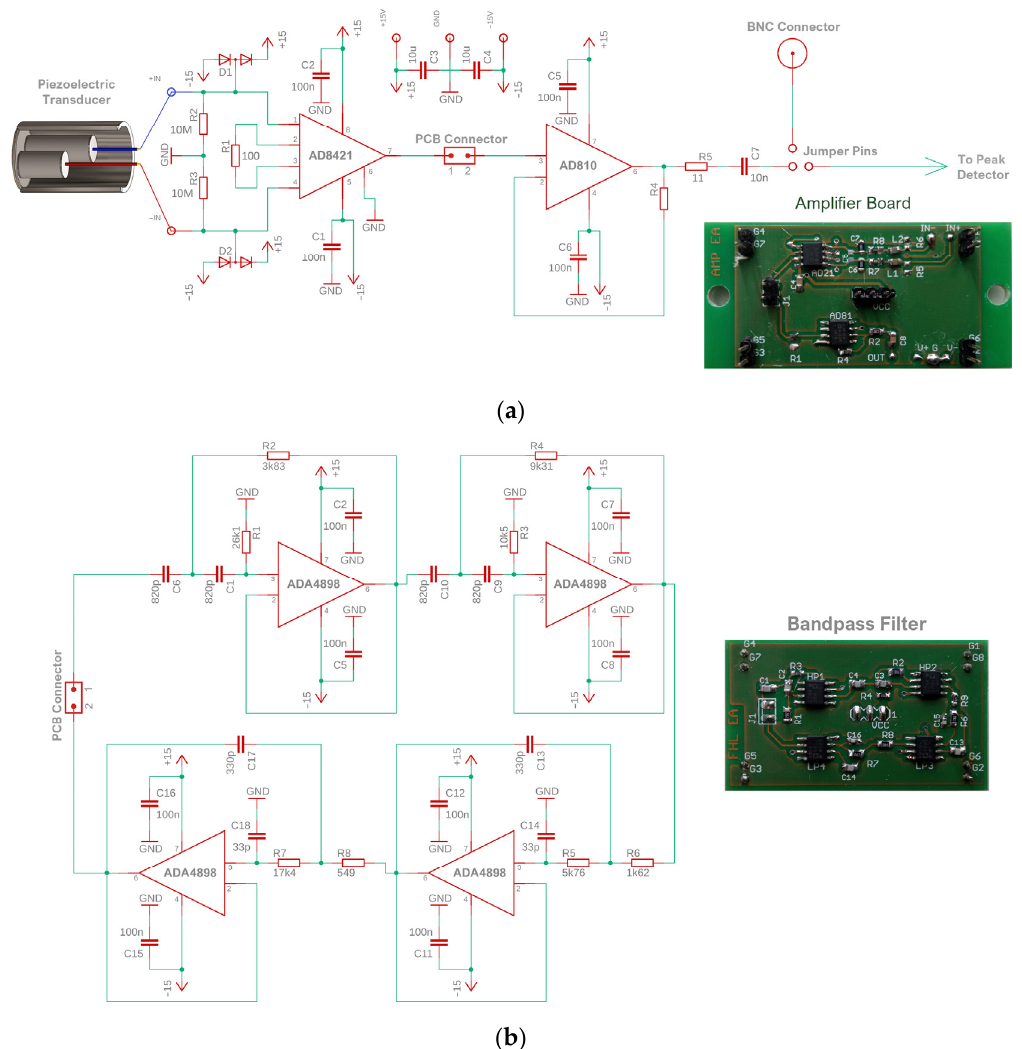
Figure 3. Electronic circuit diagram and photograph of the printed circuit board: ( a ) amplifier, ( b ) bandpass filter.